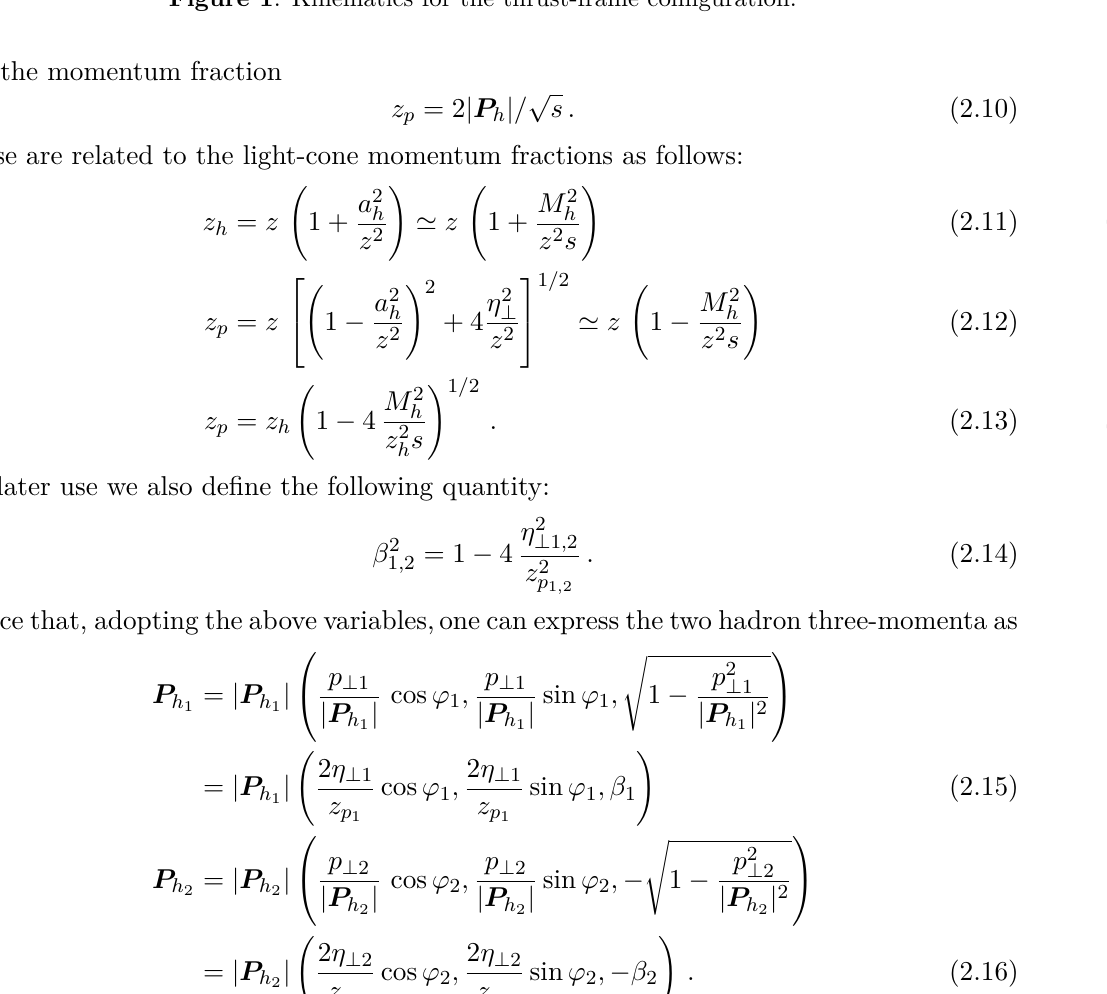
Figure 1 . Kinematics for the thrust-frame